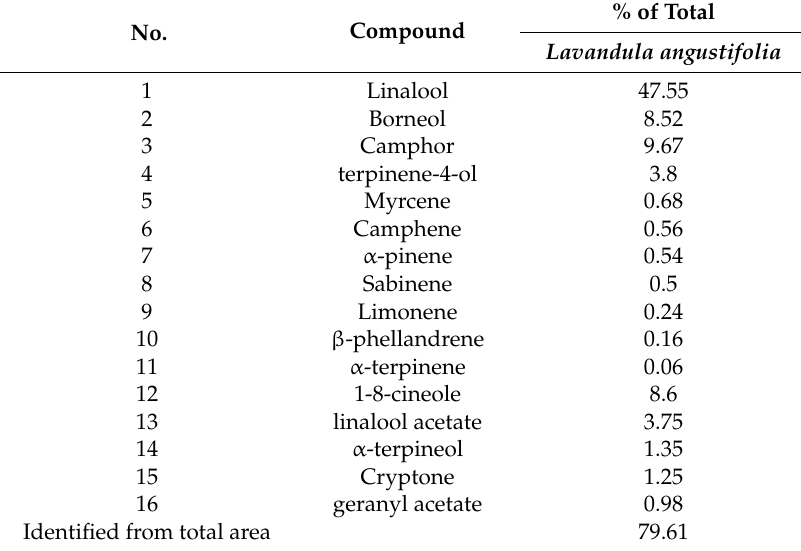
Table 2. Chemical composition of Lavandula angustifolia Sevastopolis oils from southern